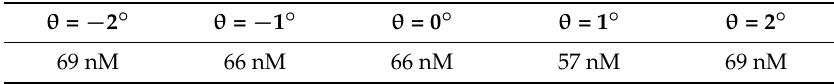
Table 1. Detection limits determined for different incident angle of the beam. The fluctuation in C is within the uncertainty of the measurements (3